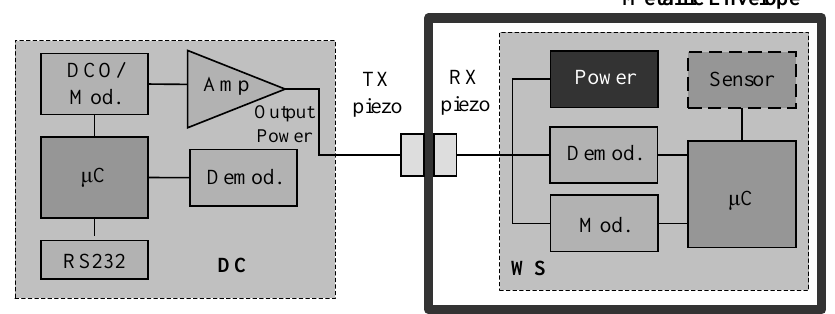
Figure 6. Ultrasonic transmission system block diagram, redrawn from Kluge et al. [3].